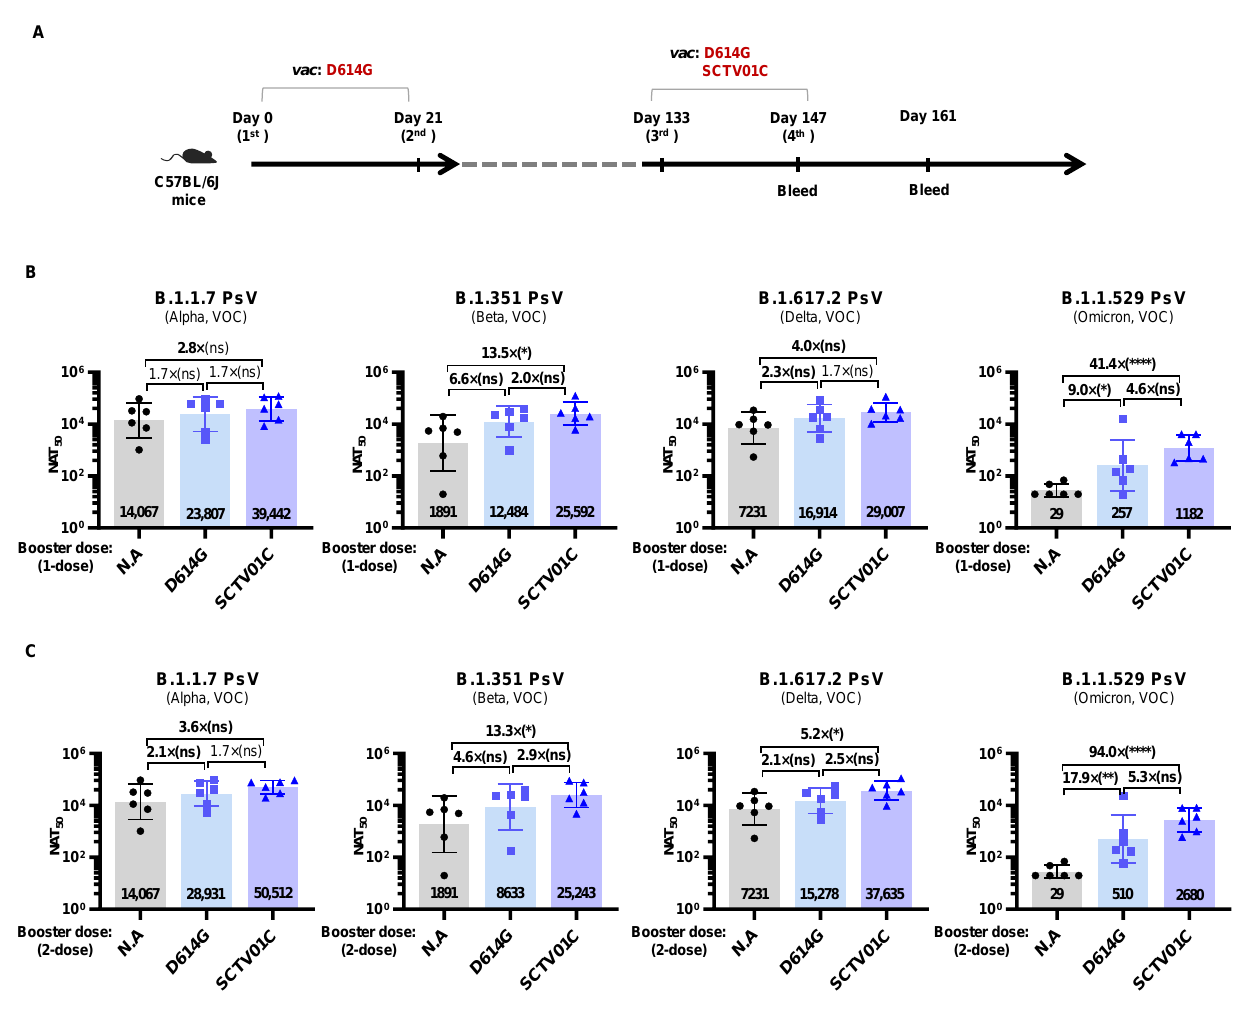
Figure 5. Humoral immune responses induced by SCTV01C or the D614G vaccine as booster shots in mice previously immunized with a 2-dose scheme of D614G vaccine. ( A ) Scheme of immunization and serum collection. C57BL/6J mice (n = 6/group) were immunized with a 2-dose scheme of D614G vaccine (0.5 µ g/dose) on days 0 and 21. On days 133 and 147, mice received two booster shots of SCTV01C (Mix Regimen; 0.5 µ g/dose/antigen) or the D614G vaccine (D614G Regimen; 0.5 µ g/dose). Neutralizing antibody titers against B.1.1.7, B.1.351, B.1.617.2 and B.1.1.529 PsV were analyzed on day 147 ( B ) and day 161 ( C ). The results are representative of 2 independent experiments. Bars show GMT ± SD. Data were log transformed and analyzed by Student’s t test (unpaired, two-tailed). * p < 0.05, ** p < 0.01, **** p < 0.0001. ns: not statistically significant. Two weeks after the second immunization with the D614G vaccine (day 35), the NAT 50 against the B.1.1.7 PSV reached 14067, with a slight decrease in NAT 50 against the B.1.617.2 PSV (NAT 50 = 7231, 1.9-fold reduction) and a sharp decrease in NAT 50